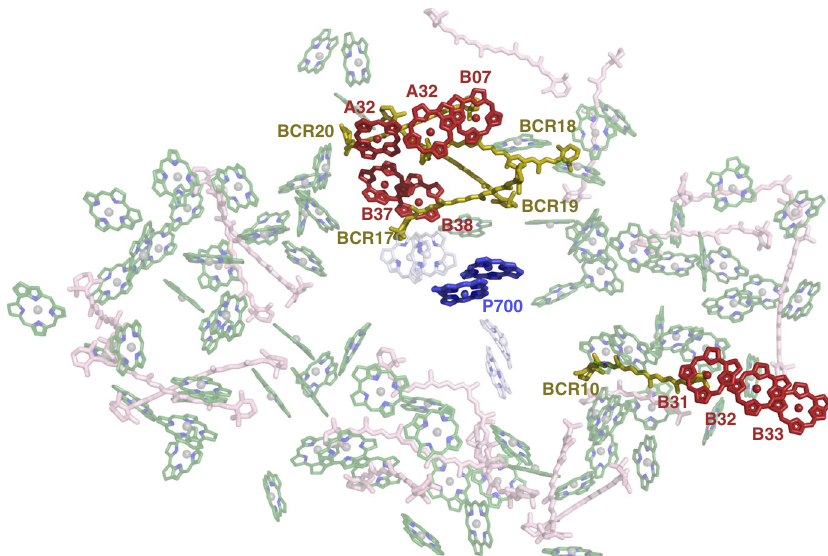
Fig. 8 Carotenoids and proposed red sites con fi guration in PSI. The structure of PSI with the core antenna Chls (green) and Cars (pink) shown in the background, predicted red Chls are in red and β -carotenes in the vicinity of the predicted red Chls are in olive, P700 Chls and the electron transport chain accessory Chls are in blue and gray,